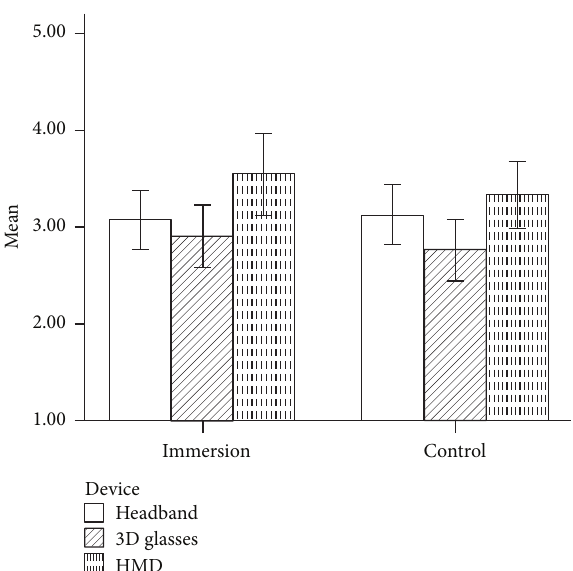
Figure 3: The means of immersion and control summated scales between the three devices. The lines represent 95% confidence interval.